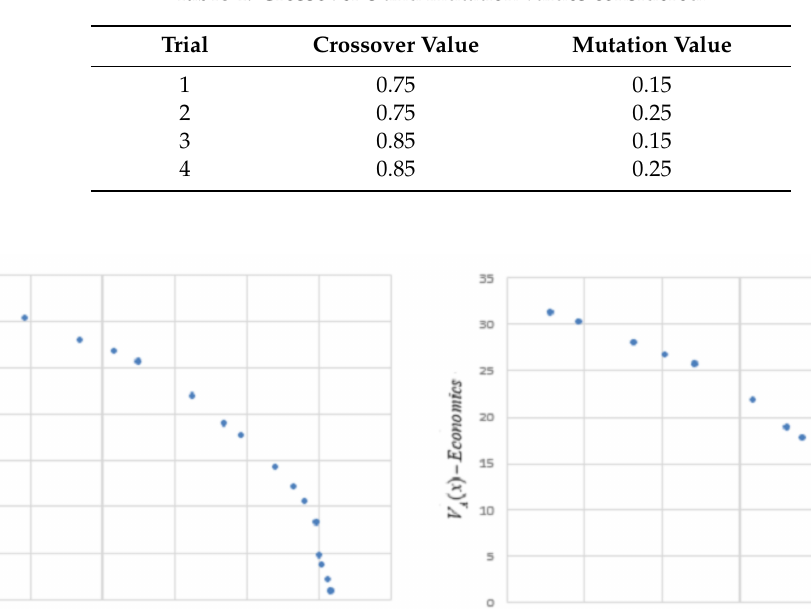
Table 4. Crossover’s and mutation values considered.